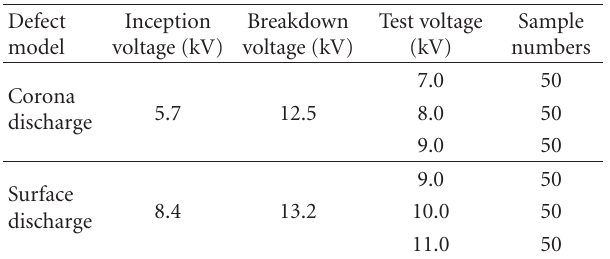
Table 3: PD experiment